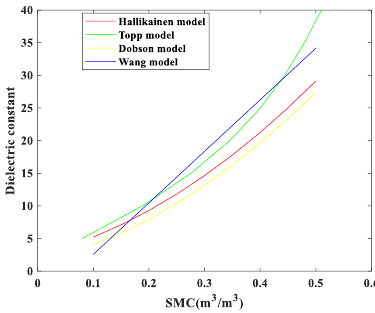
Figure 3 . The four soil models on American silty clay loam soil （ C=0.33 ， S=0.1 ） .